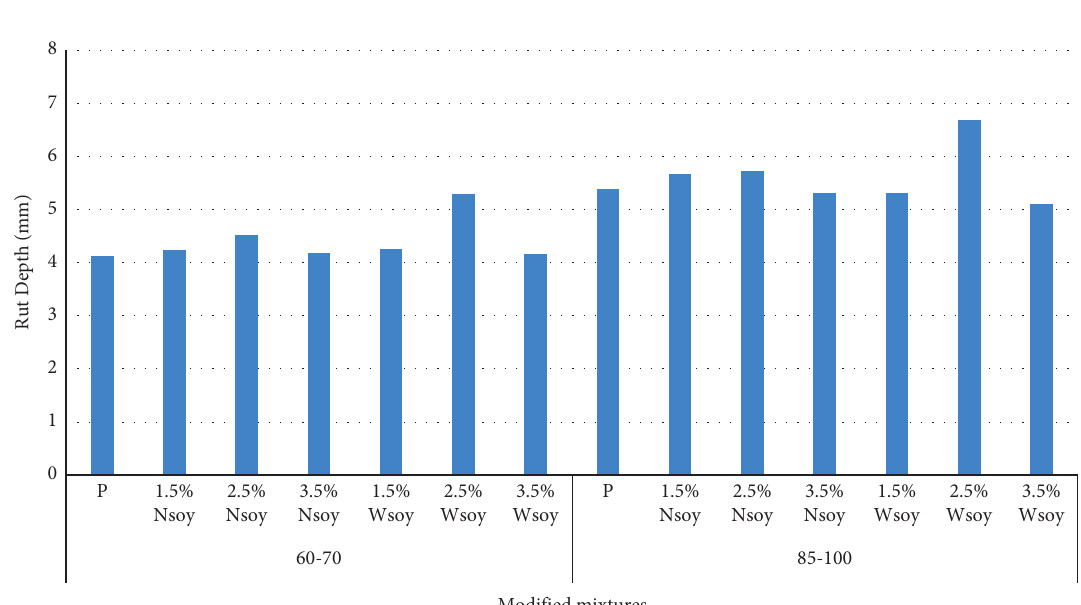
Figure 11: Unmodified and modified mixtures’ rut